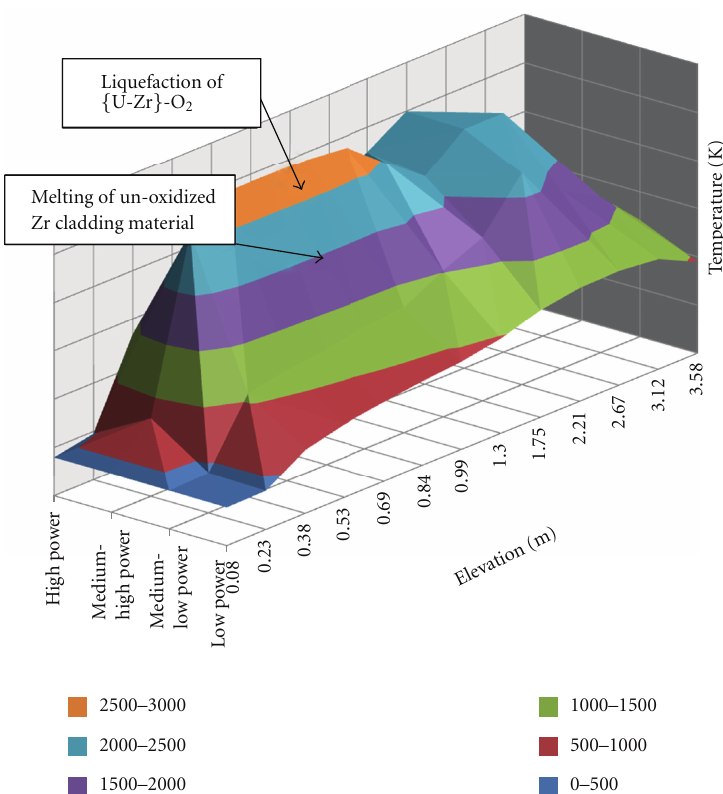
Figure 30: Core temperature at 5.1 hours for a scenario with depressurization (all emergency water injection excluding the CRDs was terminated at 4.2 hours after reactor scram).